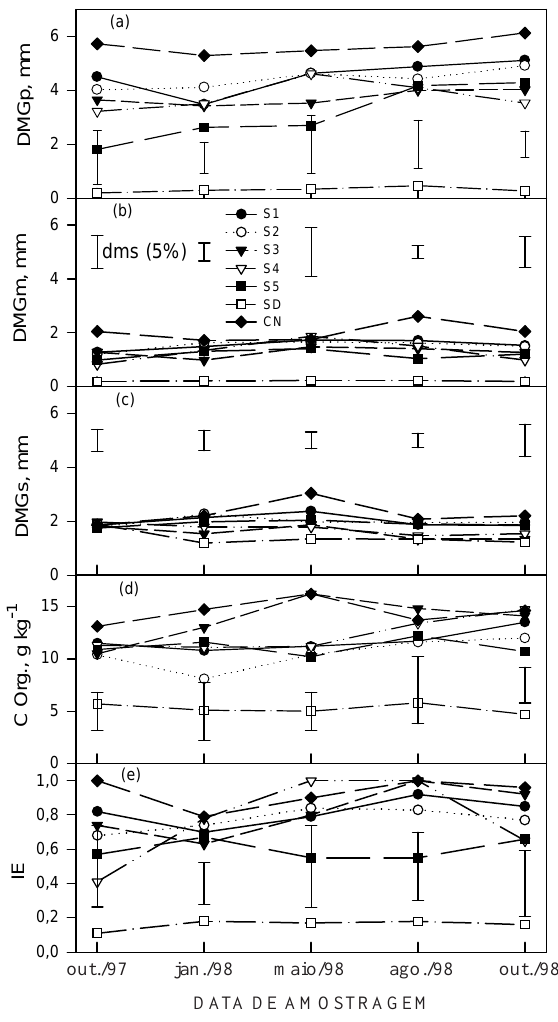
Figura 1. Diâmetro médio geométrico padrão (DMGp), diâmetro médio geométrico modifica- do (DMGm), diâmetro médio geométrico a seco (DMGs), teor de C orgânico e índice de estabi- lidade de agregados (IE) em diferentes épocas do ano para os tratamentos S1 (soja/azevém + ervilhaca/milho), S2 (soja/nabo forrageiro/mi- lho), S3 (feijão preto + mucuna/resíduos de mucuna/milho), S4 (feijão preto + feijão-de-por- co/resíduos de feijão-de-porco/milho), S5 (soja/ pousio invernal/milho), SD (solo descoberto), CN (campo natural). A barra vertical corresponde à diferença mínima significativa (DMS) com 5